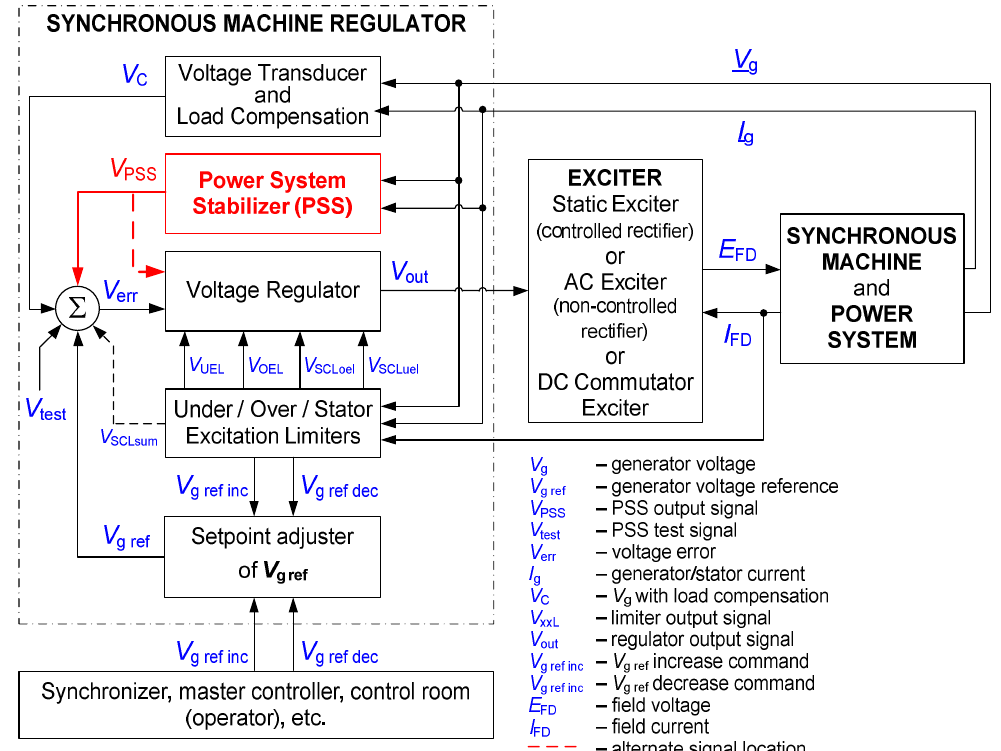
Figure 1. Block diagram of an excitation system.